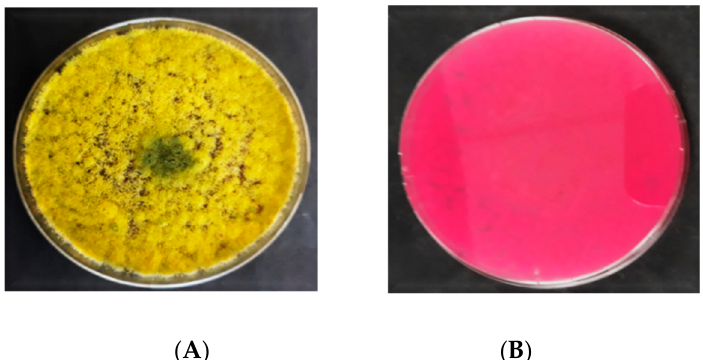
Figure 3. Colony morphology of A. flavus on dichloran rose bengal chloramphenicol (DRBC); ( A ) = obverse, ( B ) = reverse.